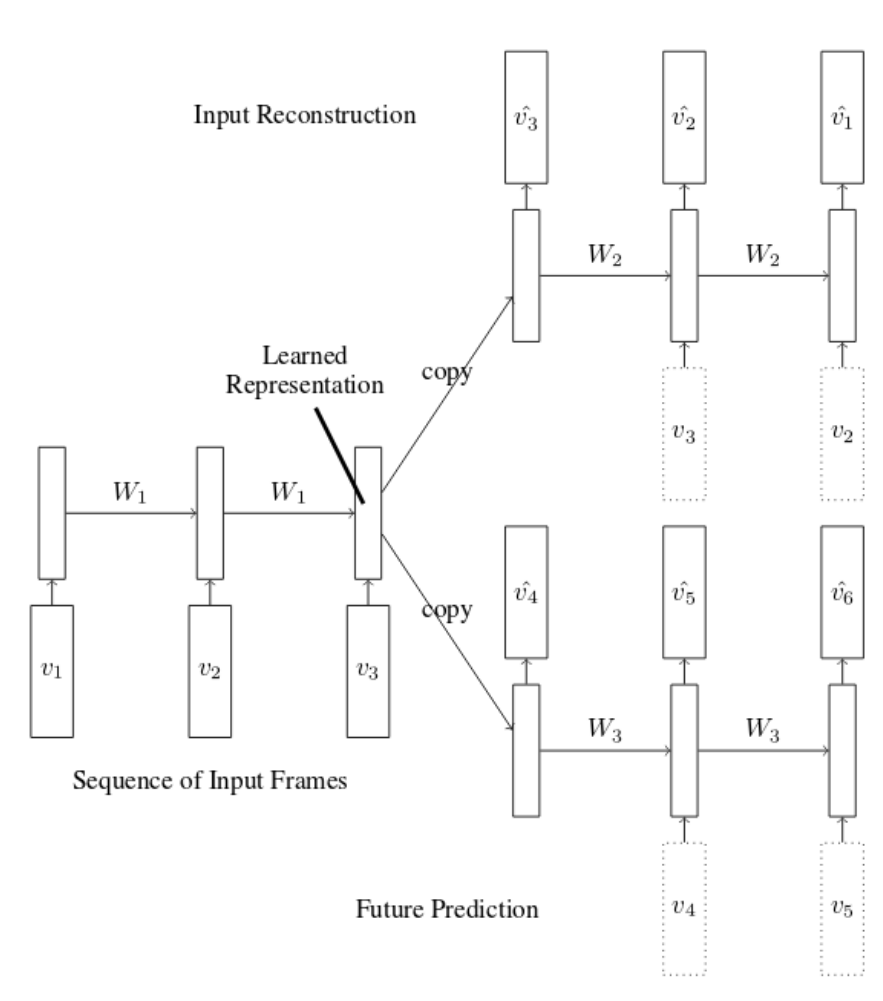
Figure 4. LSTM autoencoder by Srivastava et al.